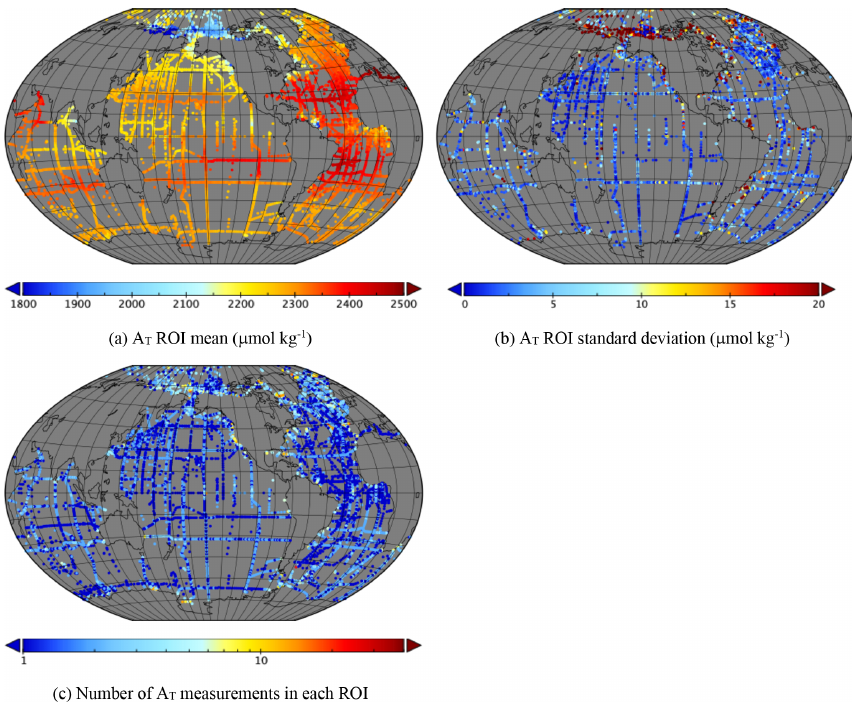
Figure 4. Statistics of A T in each ROI over the whole database (13595 ROIs). (a) ROI mean, (b) ROI standard deviation and (c) number of measurements in each ROI.